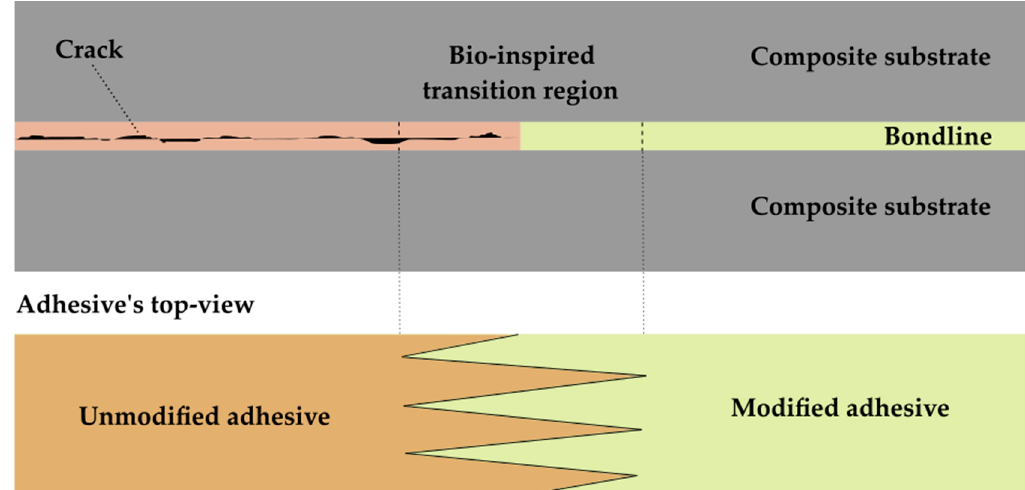
Figure 2. The modified adhesive transition concept with bio-inspired staggered region.